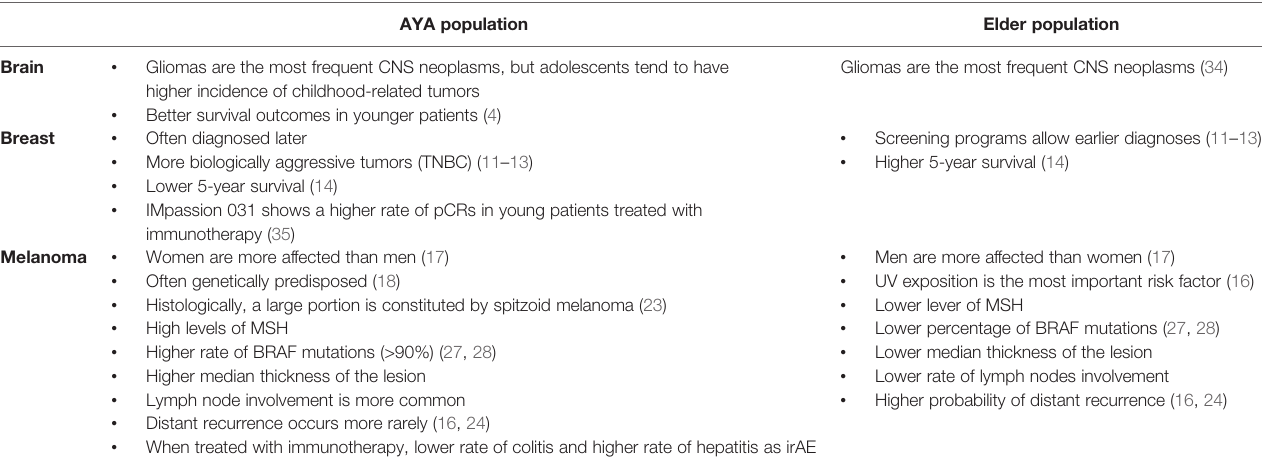
TABLE 2 | Neoplasm main differences in adolescents and young adults versus elder